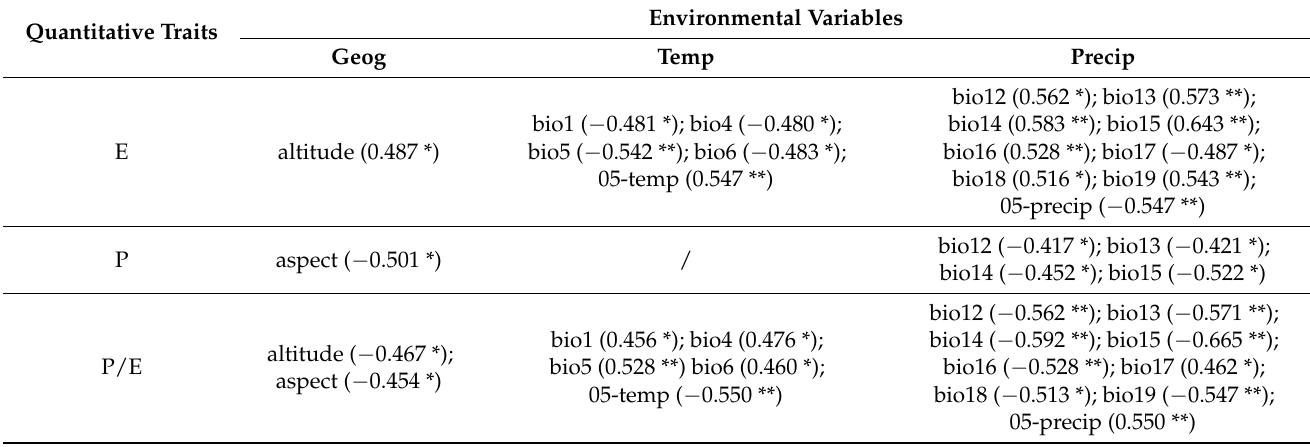
Table 3. Correlation coefficient (r) values between pollen quantitative traits and environmental